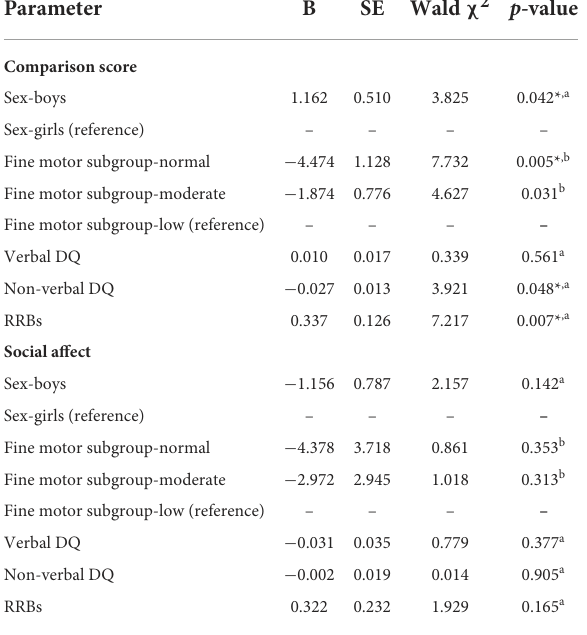
TABLE 5 Relationships between fine motor skills and social communication skills using generalized linear model. Parameter B SE Wald χ 2 p -value